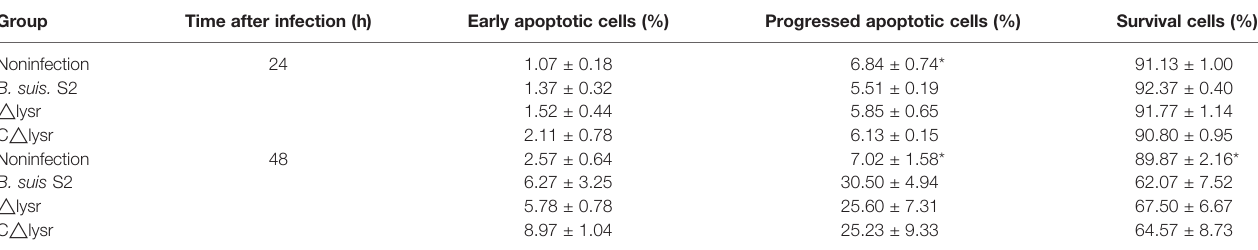
Data represent the means ± standard deviations from 3 replicates. The asterisk (*) represents signi fi cant differences (p < 0.05) in cell apoptosis in RAW264.7 cells infected by Brucella compared with that in uninfected